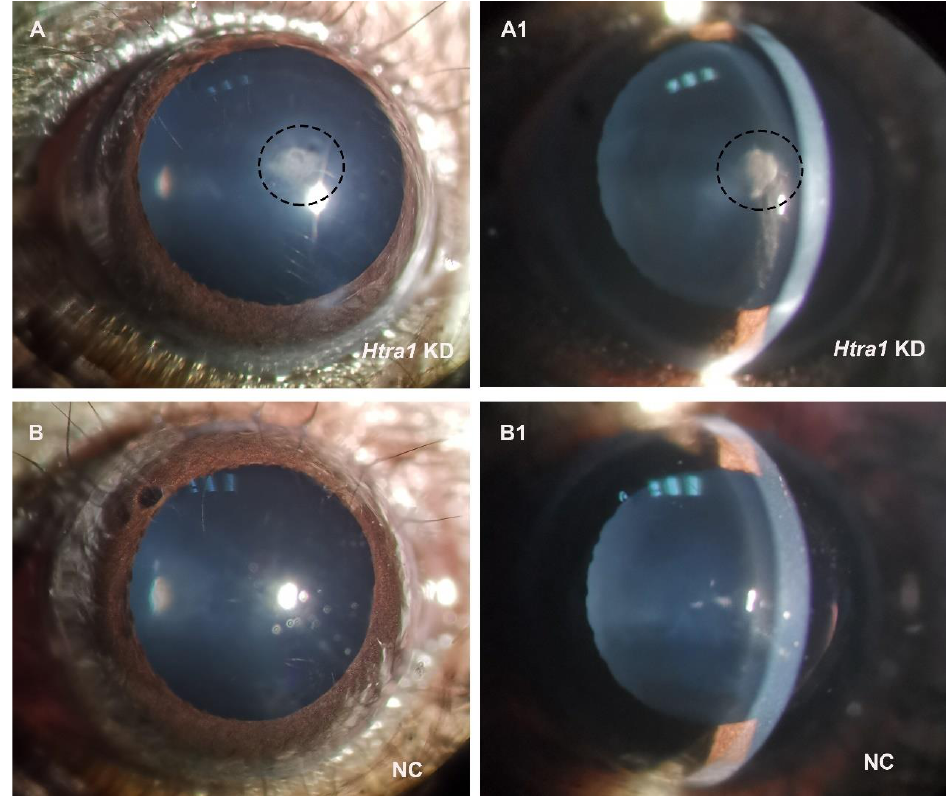
Figure 8. Images of mouse eyes after treatment of HTRA1 knockdown. ( A , A1 ) showed that down- regulation of HTRA1 induced the formation of subcapsular cataract. ( A , A1 ), as well as ( B , B1 ), were images from the same position.